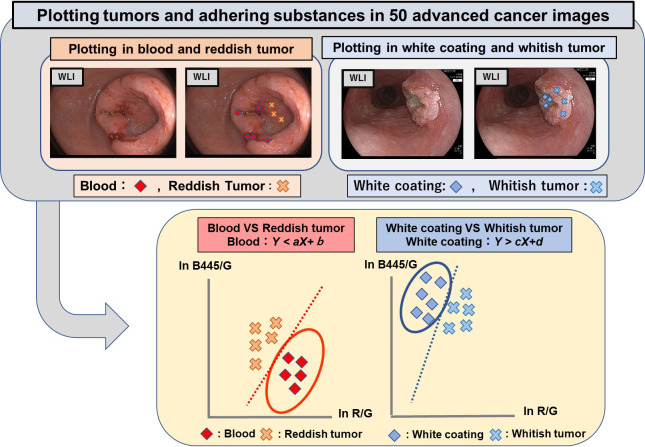
Constructing scatter diagrams and discriminating algorithms.WLI images of advanced cancers were used to generate plotted areas. Two endoscopists plotted areas considered to represent the exposed tumor and areas considered to represent adherent substances (blood and white coating) at multiple locations in each of the images of the 50 advanced cancers using ImageJ (open-source, public-domain image processing software). The plotted areas were identified by two-dimensional coordinates, the spectrum signal values (the raw pixel values proportional to the reflection rates of the substances concerned) at those areas were analyzed, and the two-dimensional scatter plots [Y axis: ln (B445/G), X axis: ln (R/G)] were produced.